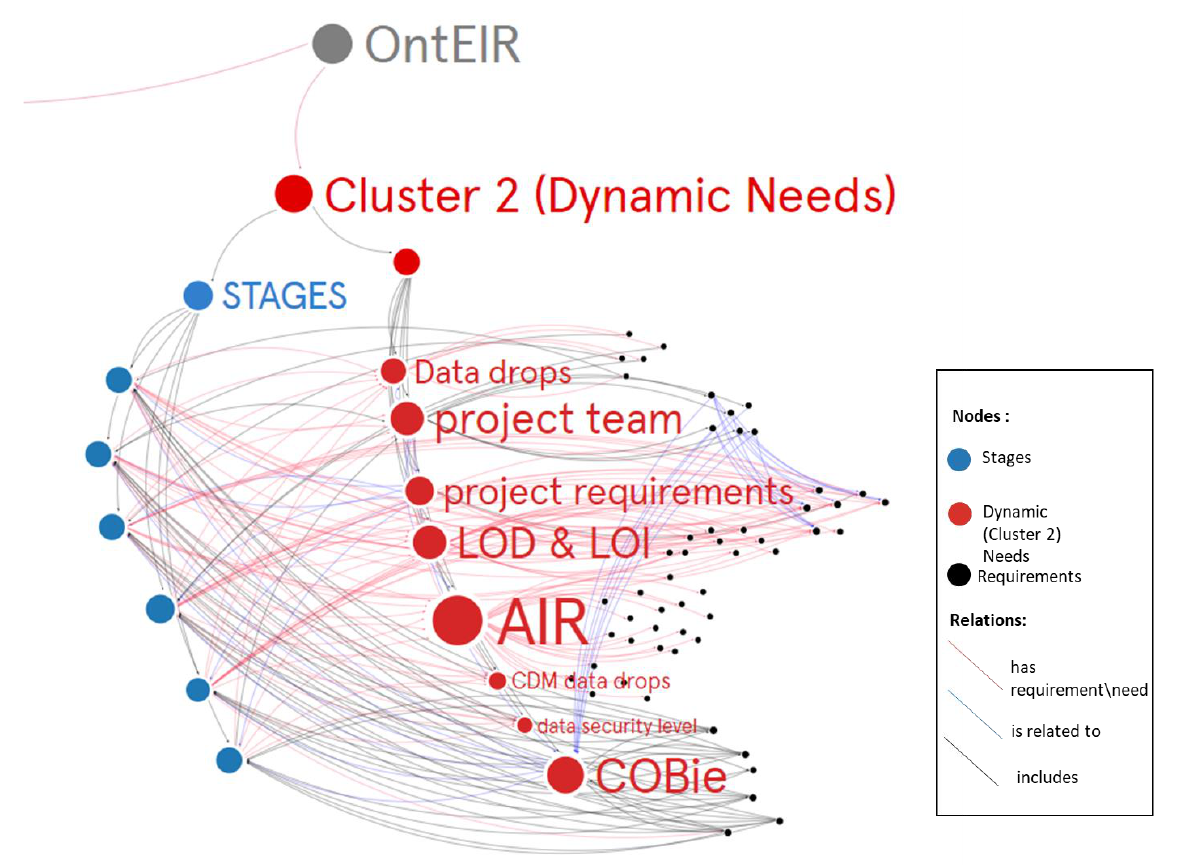
Figure 5. Dynamic needs and relationship with stages and requirements.